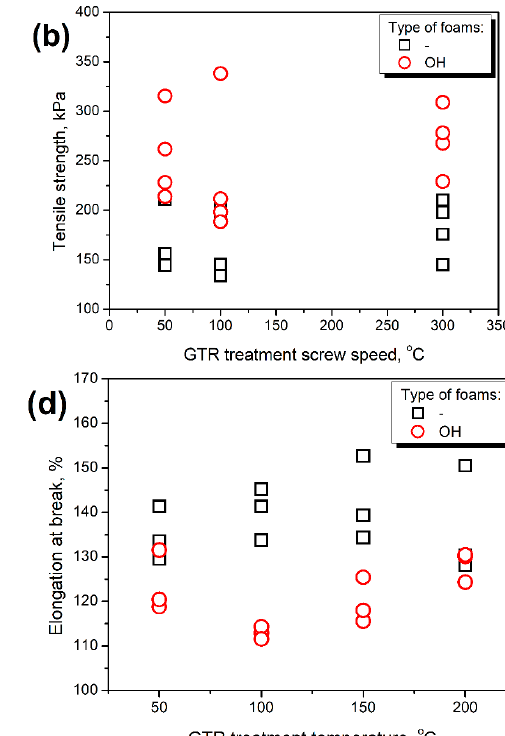
Figure 1. Stress-strain curves of composite foams containing GTR modified at ( a ) 50 °C, ( b ) 100 °C, ( c ) 150 °C, and ( d ) 200 °C.